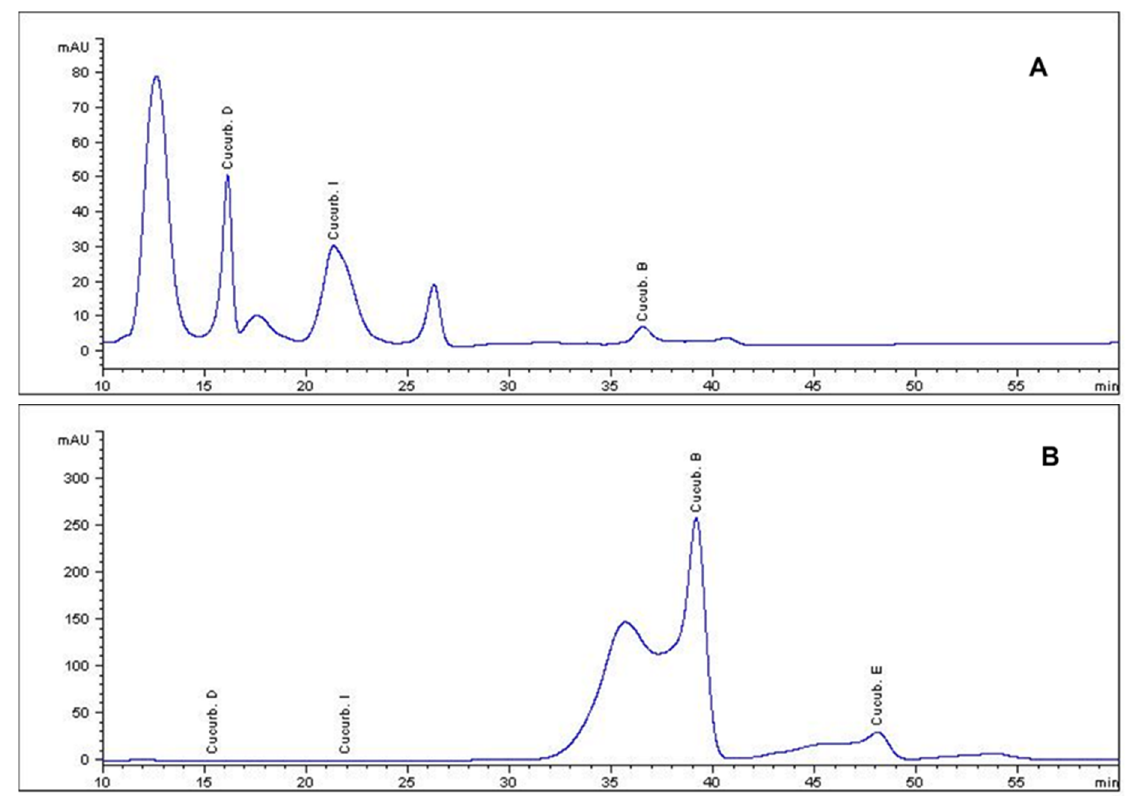
Figure 6. HPLC chromatograms for the identification of cucurbitacins in the fruit extract of Sechium edule cv. Madre Negra in dichloromethane extract. ( A ) fraction three, ( B ) fraction five.